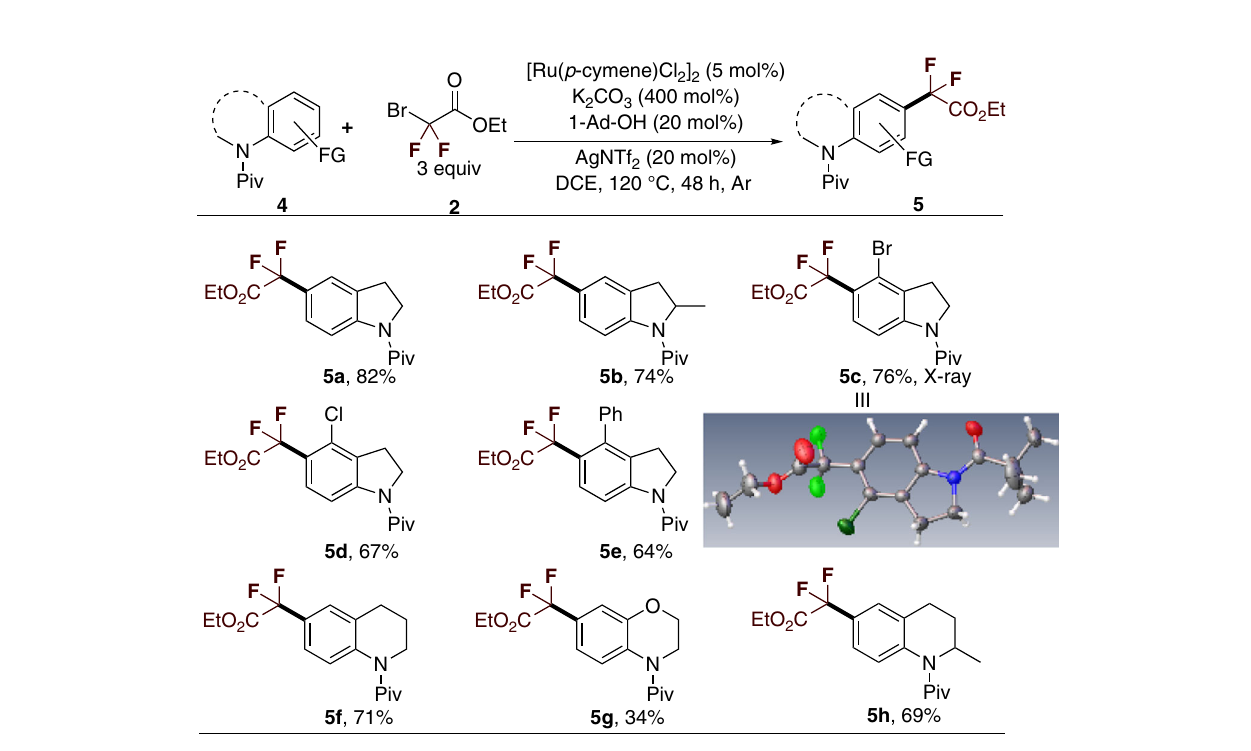
Table 3 Substrate scope of indolines and tetrahydroquinolines a